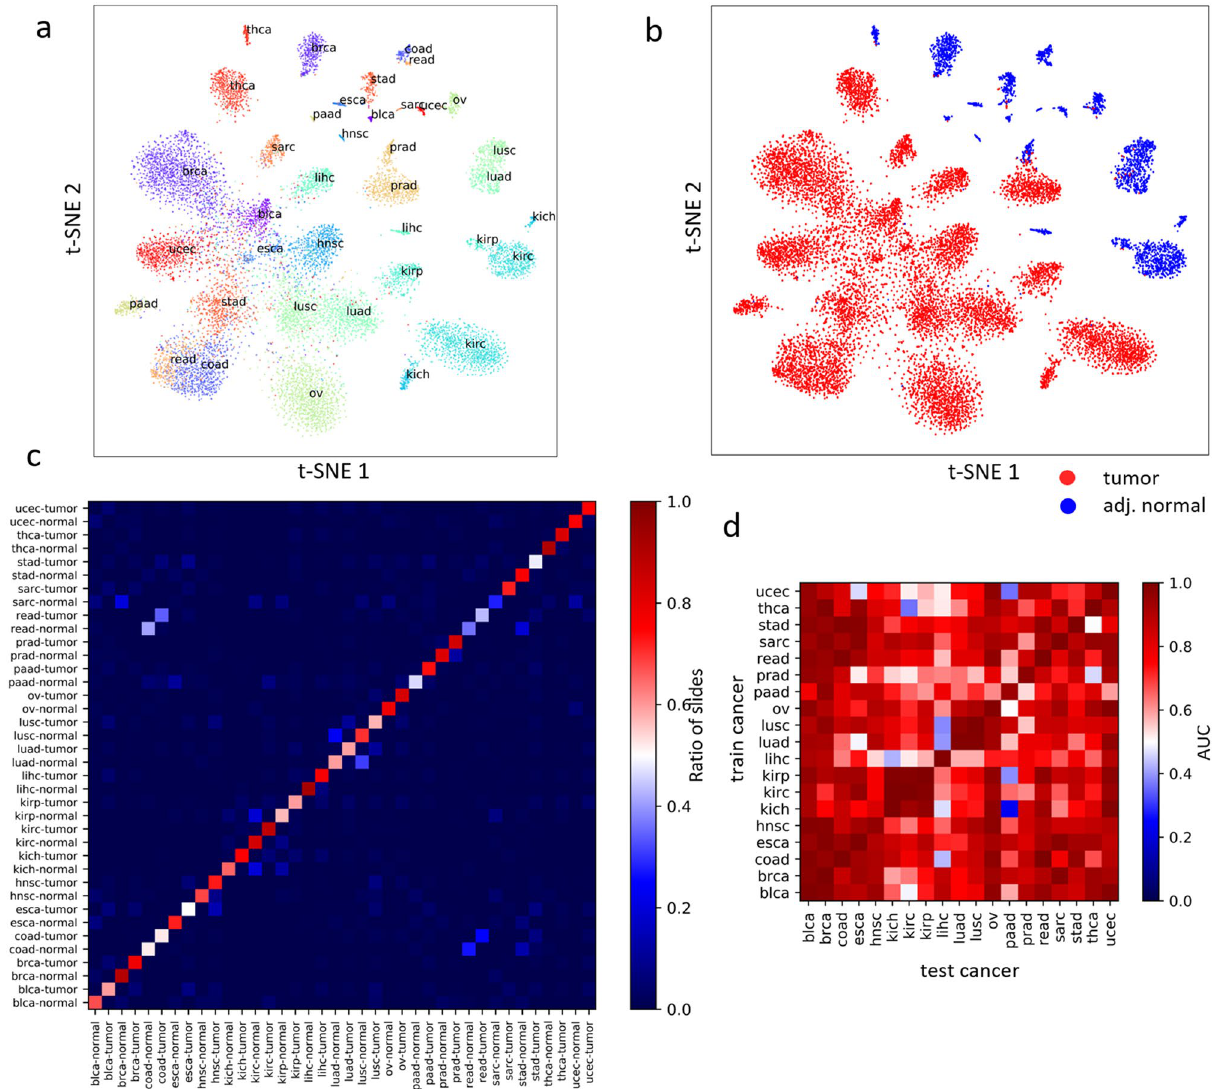
Figure 3. The joint distribution of mones reliably separates tumor and normal slides and the underlying cancer. 2D t-SNE plots of the mone-based MLDA feature space distinguishing 38 classes (19 cancers, tumor/normal status) based on ( a ) cancer type and ( b ) tumor/normal status. ( c ) Normalized confusion matrix of the 38-class mone-based logistic regression classifier. The color depicts the ratio of slides with a given true class predicted as any of the possible classes. The large diagonal values suggest the classifier has high accuracy. ( d ) The cross- classification AUCs of mone-based logistic regression tumor/normal classifier trained on each cancer and applied to all